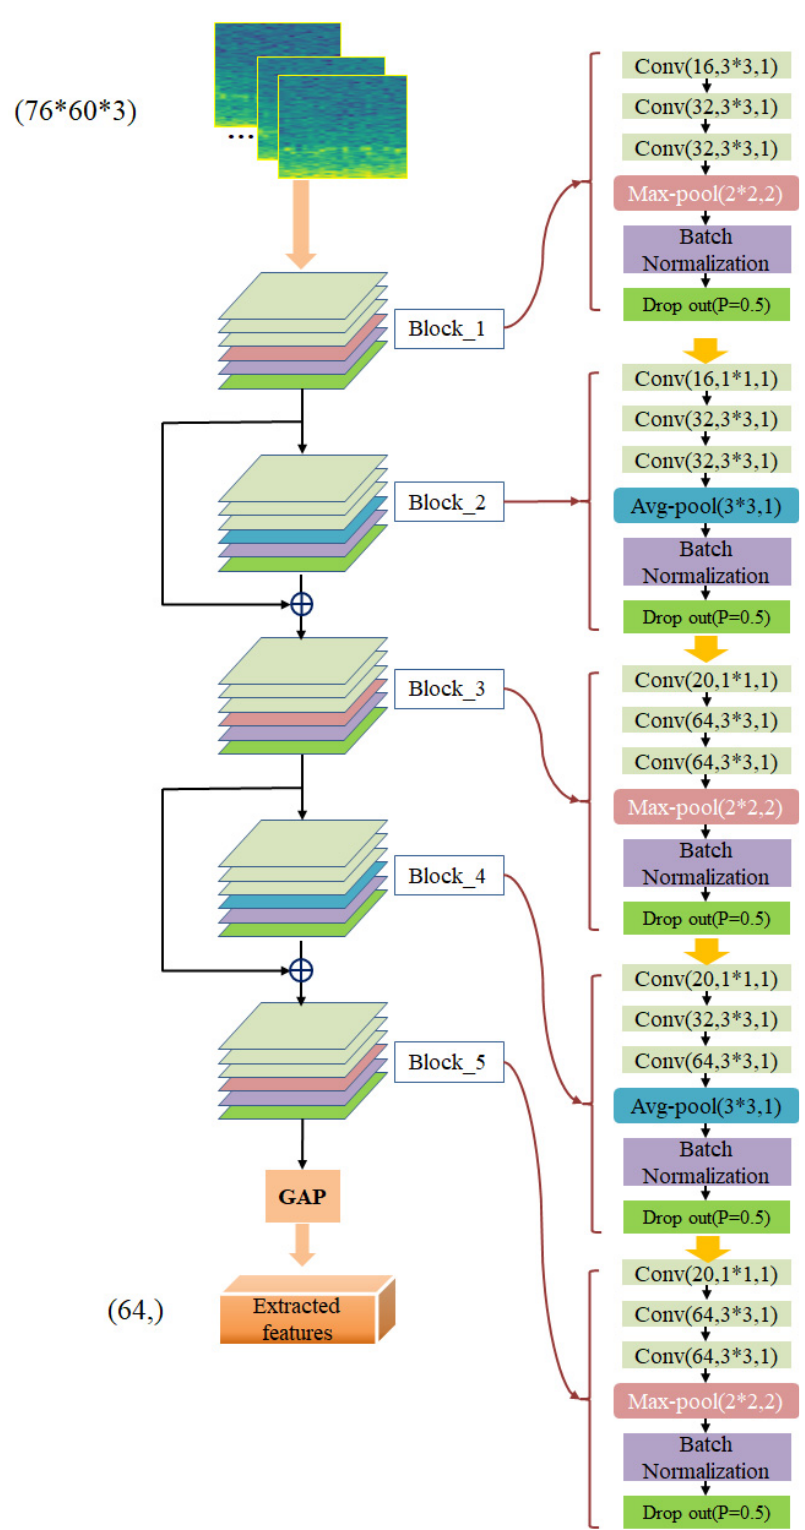
Figure 7. Feature extraction module, containing 5 CNN blocks, each CNN block internal hyperpa- rameters as shown on the right. rameters as shown on the